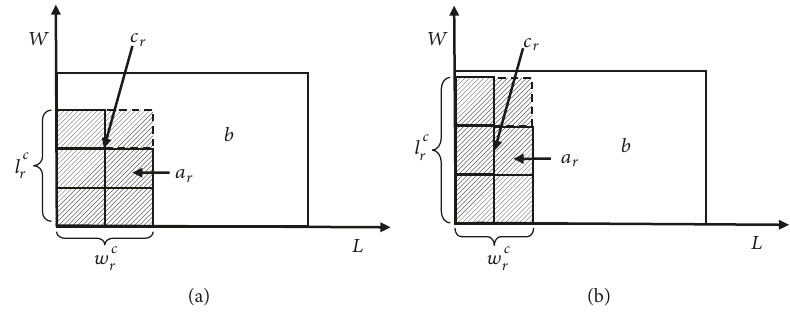
Figure 1: Same-sized rectangle-assembly